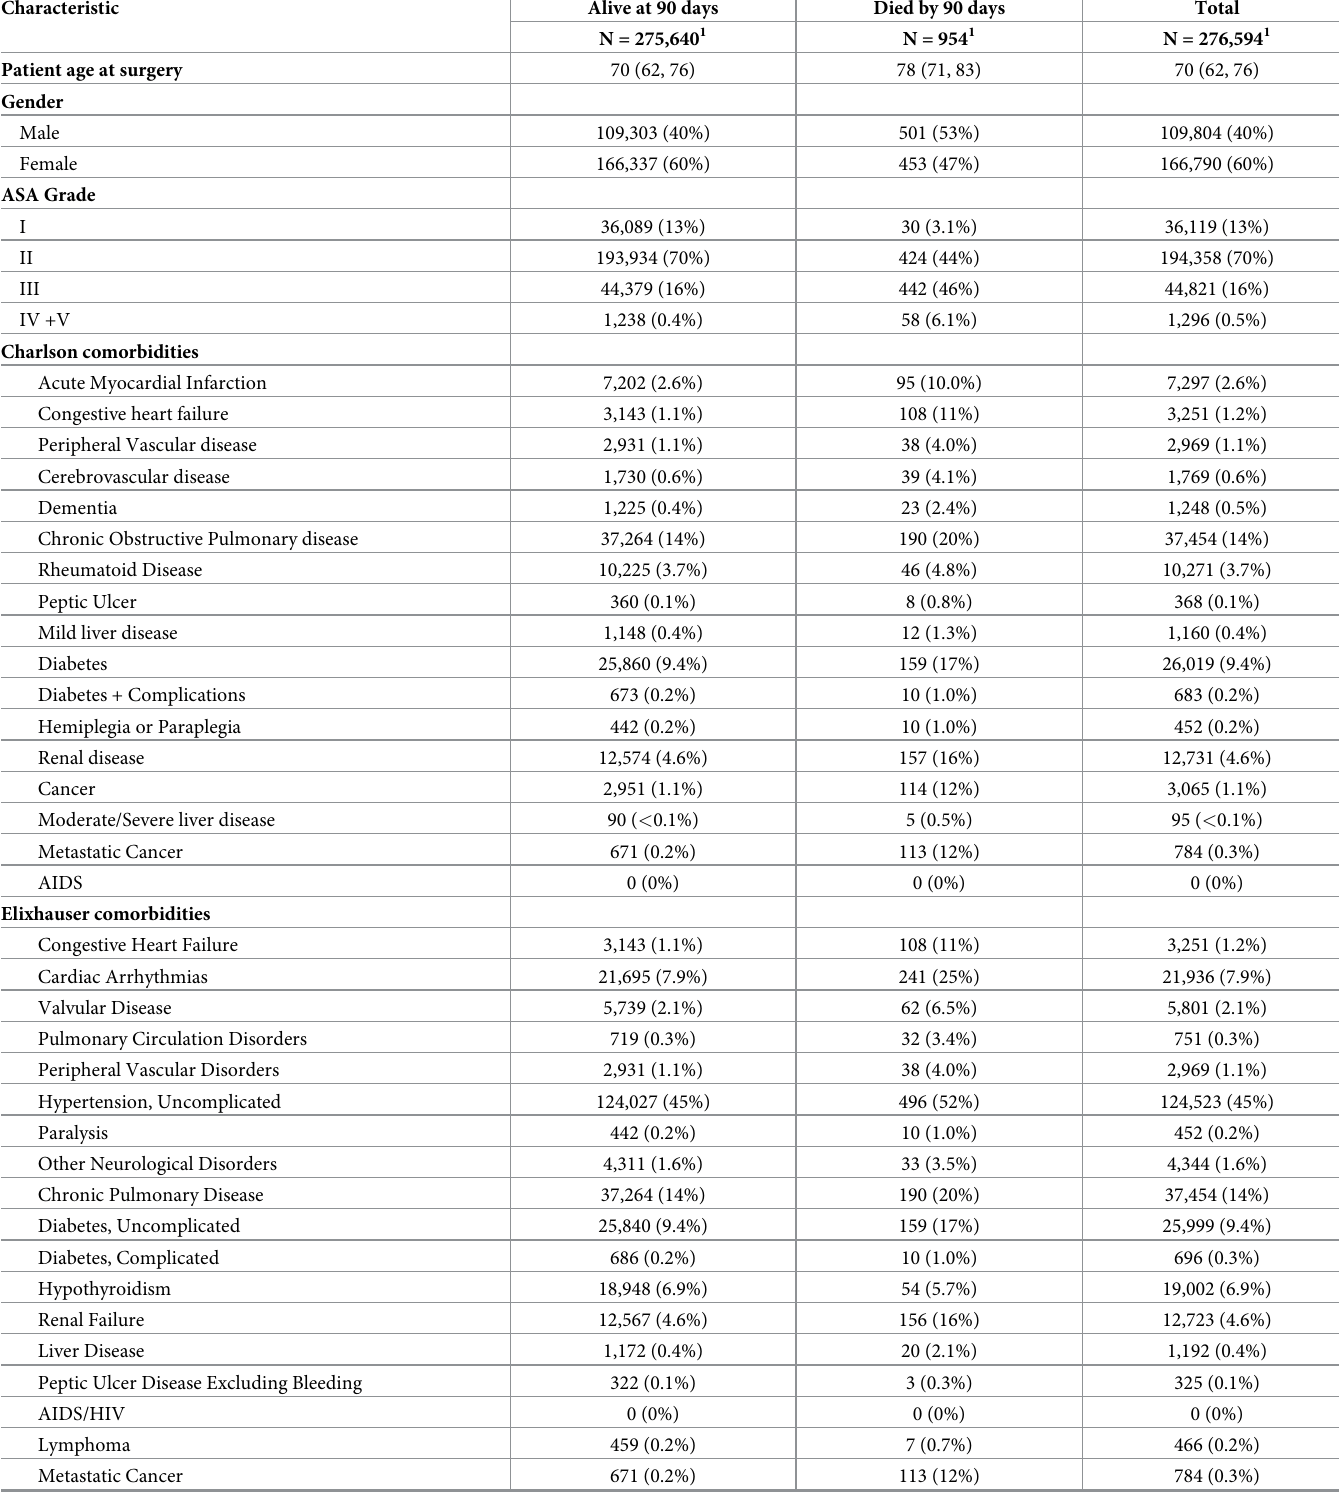
Table 1. The characteristics of people having a primary THR, including by 90-day